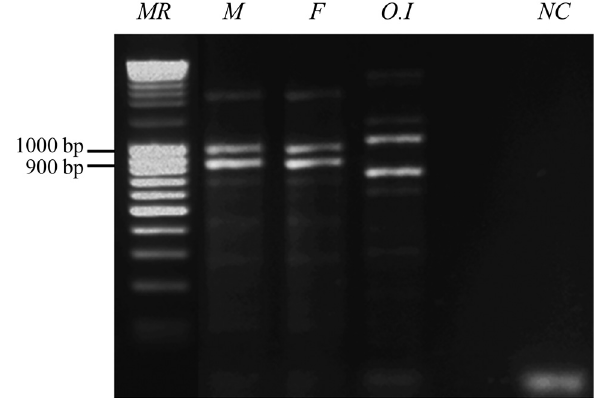
Figure1 -Amplificationproductsof Austrolebiascharrua partialgenome sequences in adult individuals. MR: Mass Ruler DNA ladder (Fermentas), M: A. charrua male, F: A. charrua female, O.l: O. latipes male (positive control), NC: negative control.